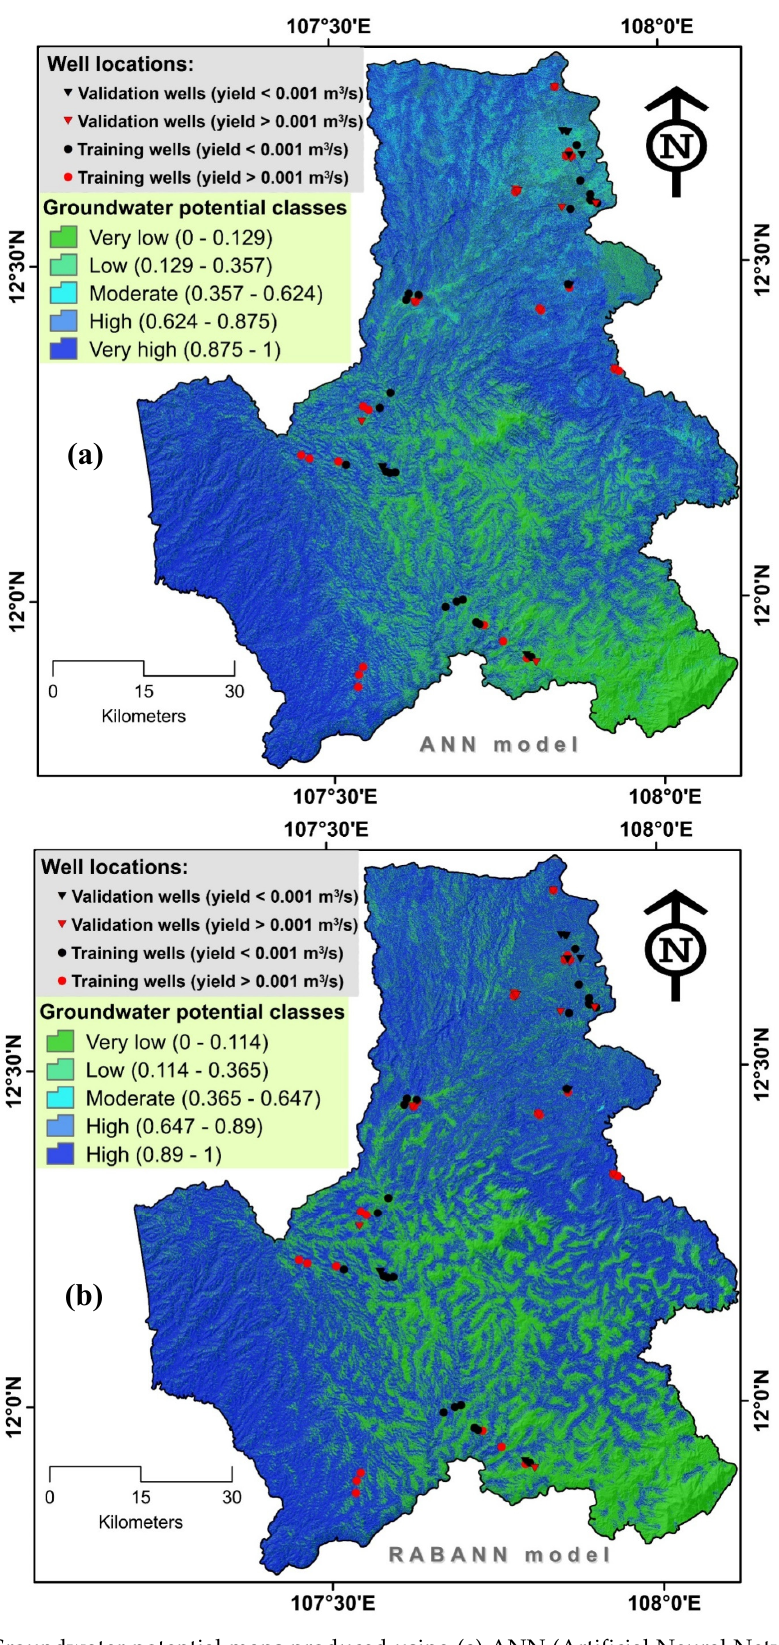
Figure 6. Groundwater potential maps produced using ( a ) ANN (Artificial Neural Networks) and ( b ) RABANN (the ensemble model of RAB and ANN).